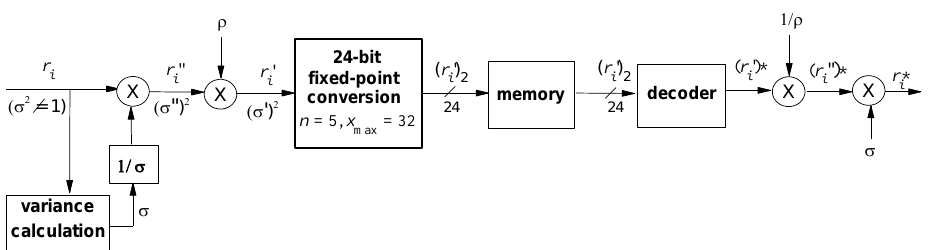
Figure 3. Conversion to the 24-bit fixed-point format with the double adaptation.